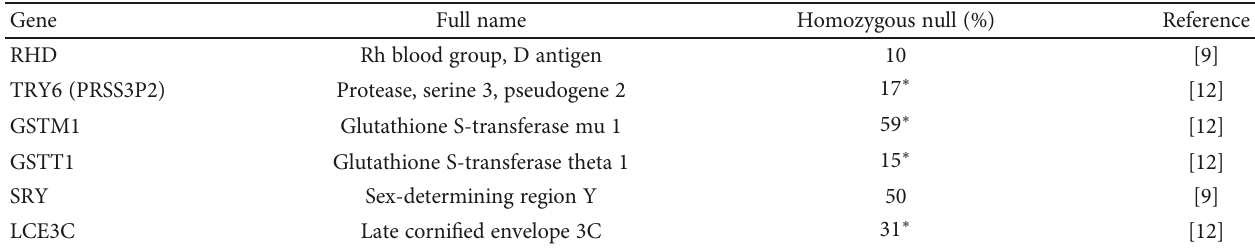
Table 1: Frequency of null phenotype for the six genes of interest.